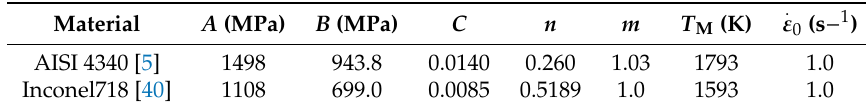
Table 2. Johnson and Cook (JC) Materials constants and parameters adopted for Equation (12) in the FEM simulations.